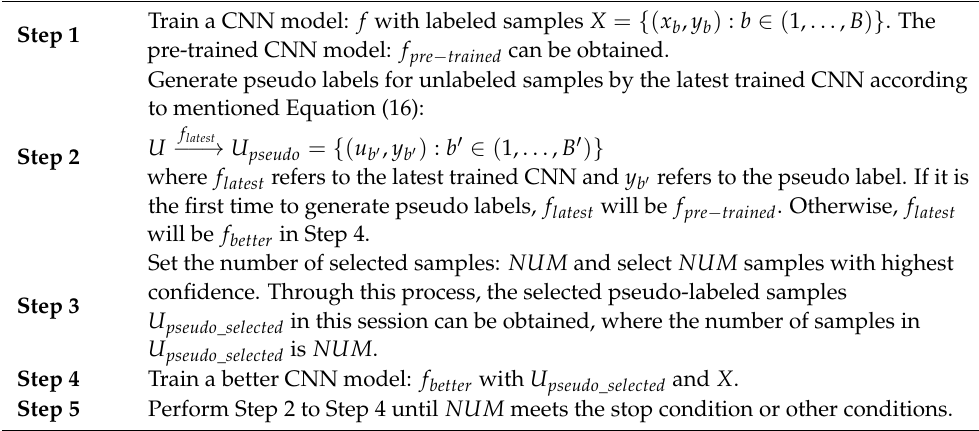
Algorithm 2. The algorithm of accomplishing the semi-supervised classification task based on CNN and selecting samples by controlling the